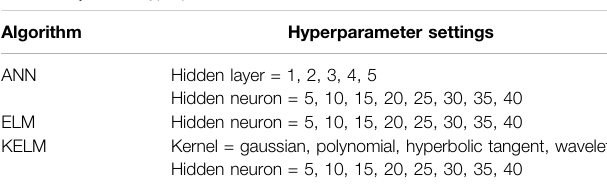
TABLE 2 | List of hyperparameters tested for ANN, ELM, and